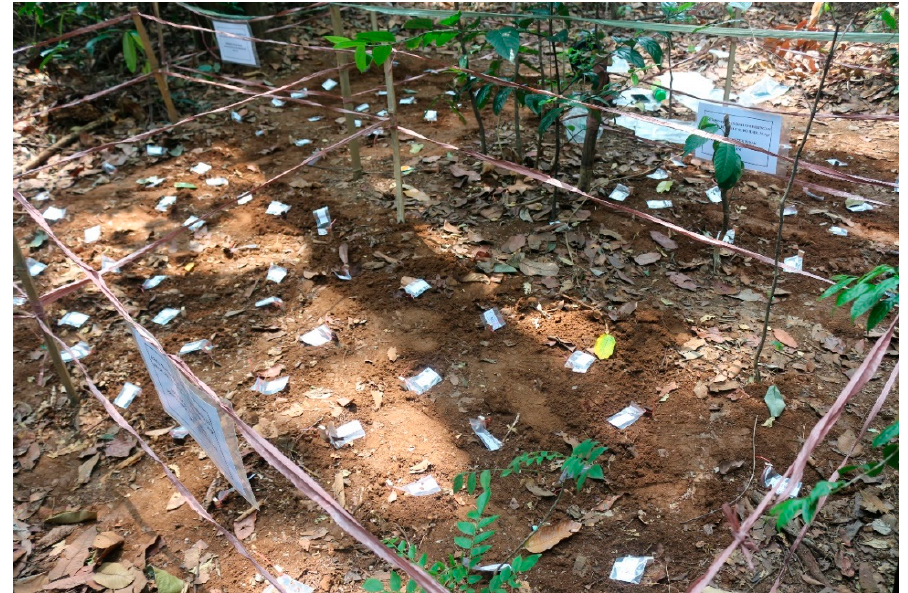
Figure 1. Subterranean termite field test.